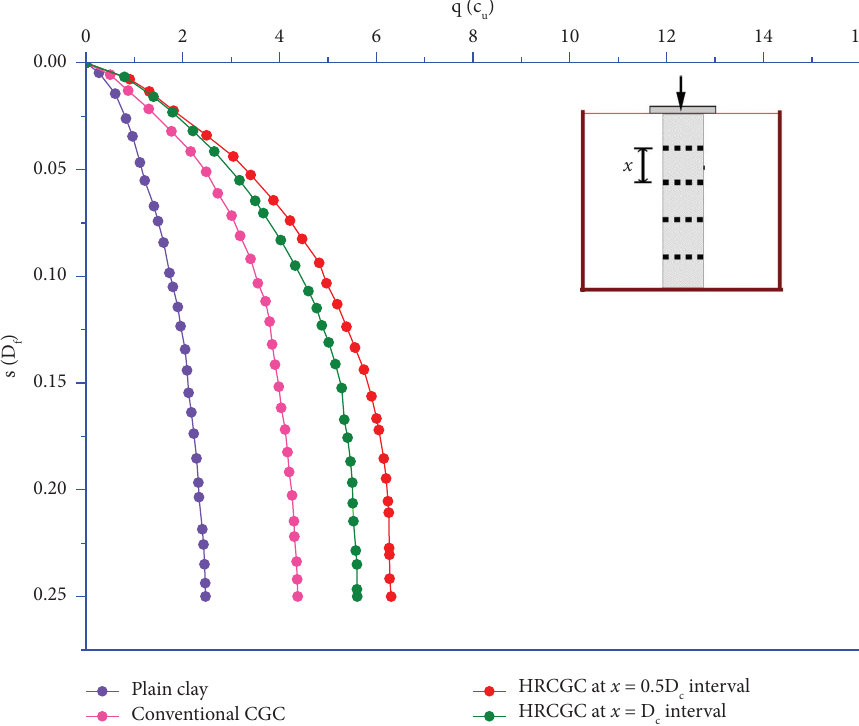
Figure 16: q / q u versus s / D f curve for CGC having horizontal reinforcement at various depths.